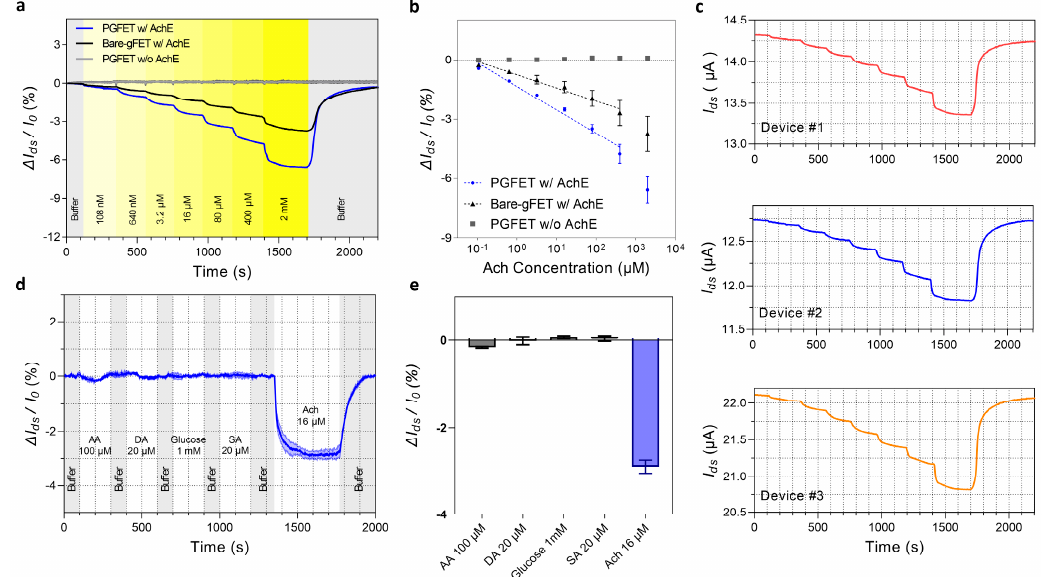
Figure 4. Ach − sensing performance of an AchE − immobilized bare − gFET and PGFET. ( a ) The real − time responses with increasing Ach concentrations in AchE − immobilized PGFETs (blue line), AchE − immobilized bare − gFETs (black line), and PGFETs without AchE immobilization (gray). ( b ) The plots fitted by linear regression as a function of Ach concentrations from 108 nM to 400 μ M for the sensitivity analysis of each biosensor. ( c ) The real − time I ds responses of individual PGFETs depending on various Ach concentrations. ( d ) The real − time responses of the AchE − immobilized PGFET with various interfering molecules and Ach (16 μ M). The light band around the curve represents pointwise 95 % confidence intervals derived from n = 3 independent measurements. ( e ) Bar graphs representing the comparison between the signal of the target analyte and interferences. The average ± standard deviation was calculated from n = 3 independent samples.